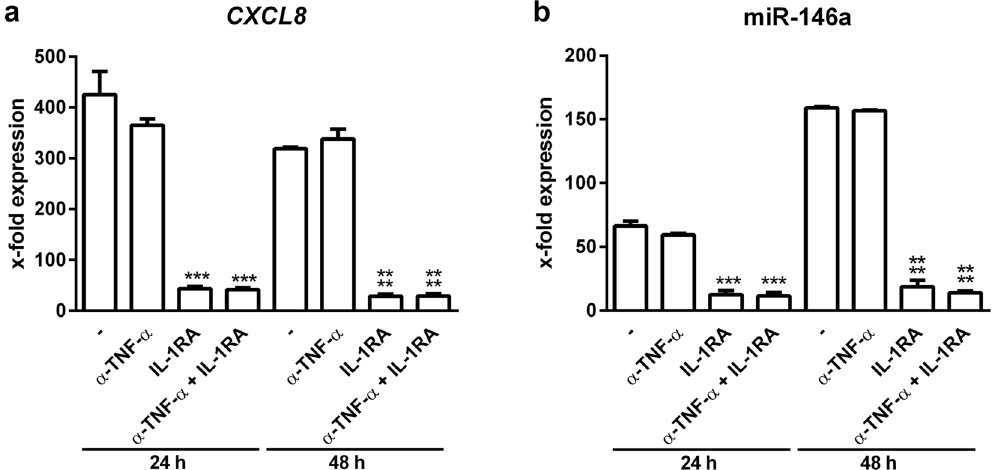
Figure 3. THP-1-derived IL-1 β induces pro-inflammatory response in A549 cells. ( a , b ) Response of A549 cells to vesicle-free supernatant from L . pneumophila -infected THP-1 cells. THP-1 cells were infected with L . pneumophila (MOI 0.5) for 24 h. A549 cells were pre-incubated for 1 h with a neutralizing TNF- α antibody ( α -TNF- α ) or an IL-1 receptor antagonist (IL-1RA) alone or in combination, respectively. Cells were then incubated with the vesicle-free supernatant for 24 or 48 h, respectively. RNA was collected and used for expression analysis of CXCL8 ( a ) and miR-146a ( b ). Data are shown as mean + SEM of three independent experiments. *** p < 0.001, **** p < 0.0001 compared to corresponding supernatant treated